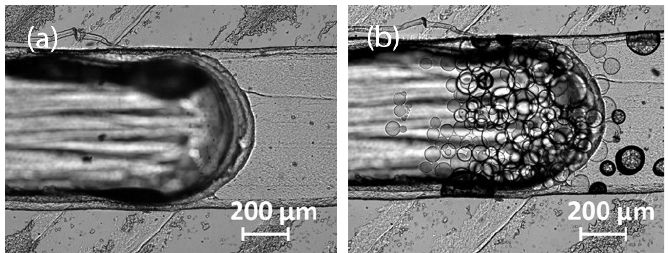
Figure 10. Sieve structure and particle retention with a microfluidic chip fabricated with the Ultimaker S5. ( a ) Sieve structure. ( b ) Sieve structure with retained spherical particles (Ø: 45–165 µ m).